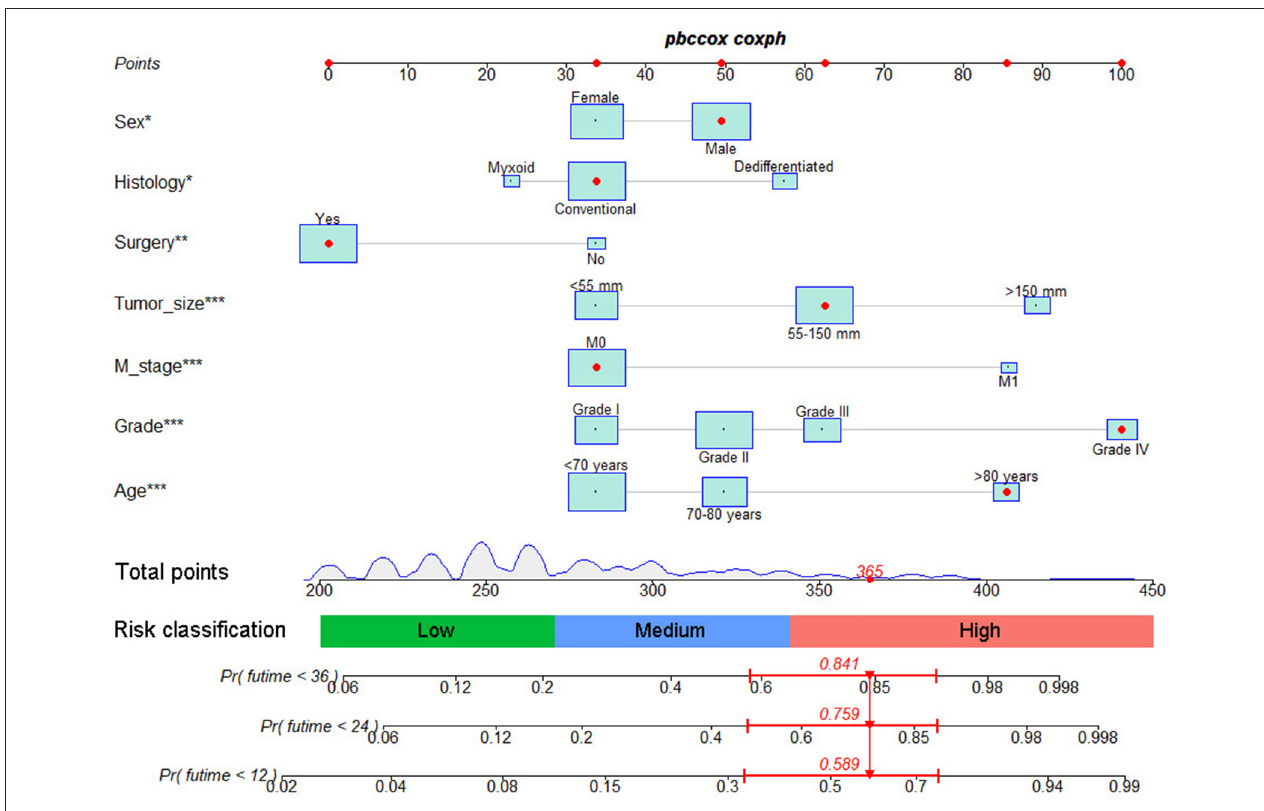
FIGURE 3 | The graph showed nomogram for predicting 12-, 24-, and 36-month OS of elderly patients with CHS.